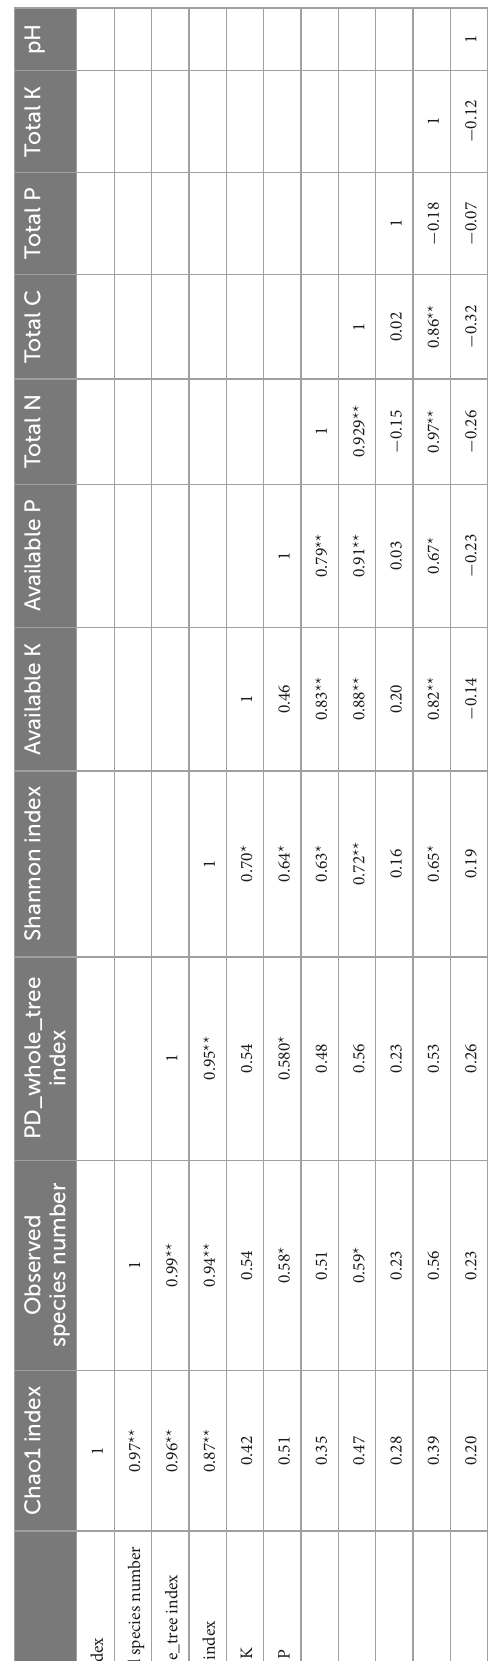
on the environmental adaptability of bacterial communities in rice rhizosphere soil showed that available K played a decisive role in regulating bacterial community assemblage (Tian et al., 2022). The study on Camellia sinensis rhizosphere soil from Qinling Mountains revealed N content had the greatest effect on the bacterial diversity at genus level, and C, K and pH were positively correlated with Pedobacter and Mucilaginibacter genera (Wang M. J. et al., 2021). However, our results revealed the relative abundance of Acidobacteria and Proteobacteria positively correlated with total N while the relative abundance of Chloroflexi showed a significant negative correlation with total N. Studies on the soil bacterial diversity of four pinus species forests revealed that Acidobacteria was correlated with pH, and the Chloroflexi was correlated with total N (Deng et al., 2019). Fei et al. (2020) also found that the relative abundance of Proteobacteria was positively correlated with the soil total N content. In this study, the total N content was the highest at lower thinning reserve density, and the relative abundance of Proteobacteria was also the highest. The soil in stands with intermediate (1,200 stems ha − 1 ) and high (1,875 stems ha − 1 ) density is poorer, and the relative abundance of the Chloroflexi